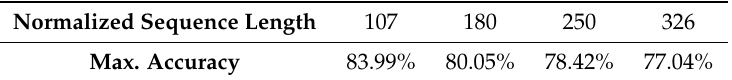
Table 2. Mean accuracy of the k-fold cross-validation analysis produced by Imran et al. [9] with respect to zero-padding on their 5 layer 1D-CNN.